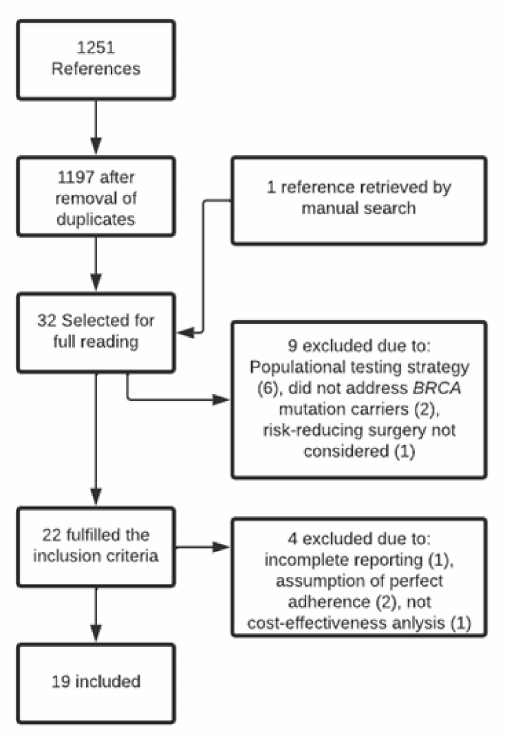
Figure 1. Study selection process. The health economic models included covered health systems from different countries, including Norway [19], Australia [20,31,35], Brazil [32,33], the United Kingdom [18,21,25,34], the United States [22,23,28], Canada [24,26,27], Spain [30], and Germany [9]. Table 1 pro- vides an overview of the included models and their uptake rates. Table 1. Characteristics of modeling studies